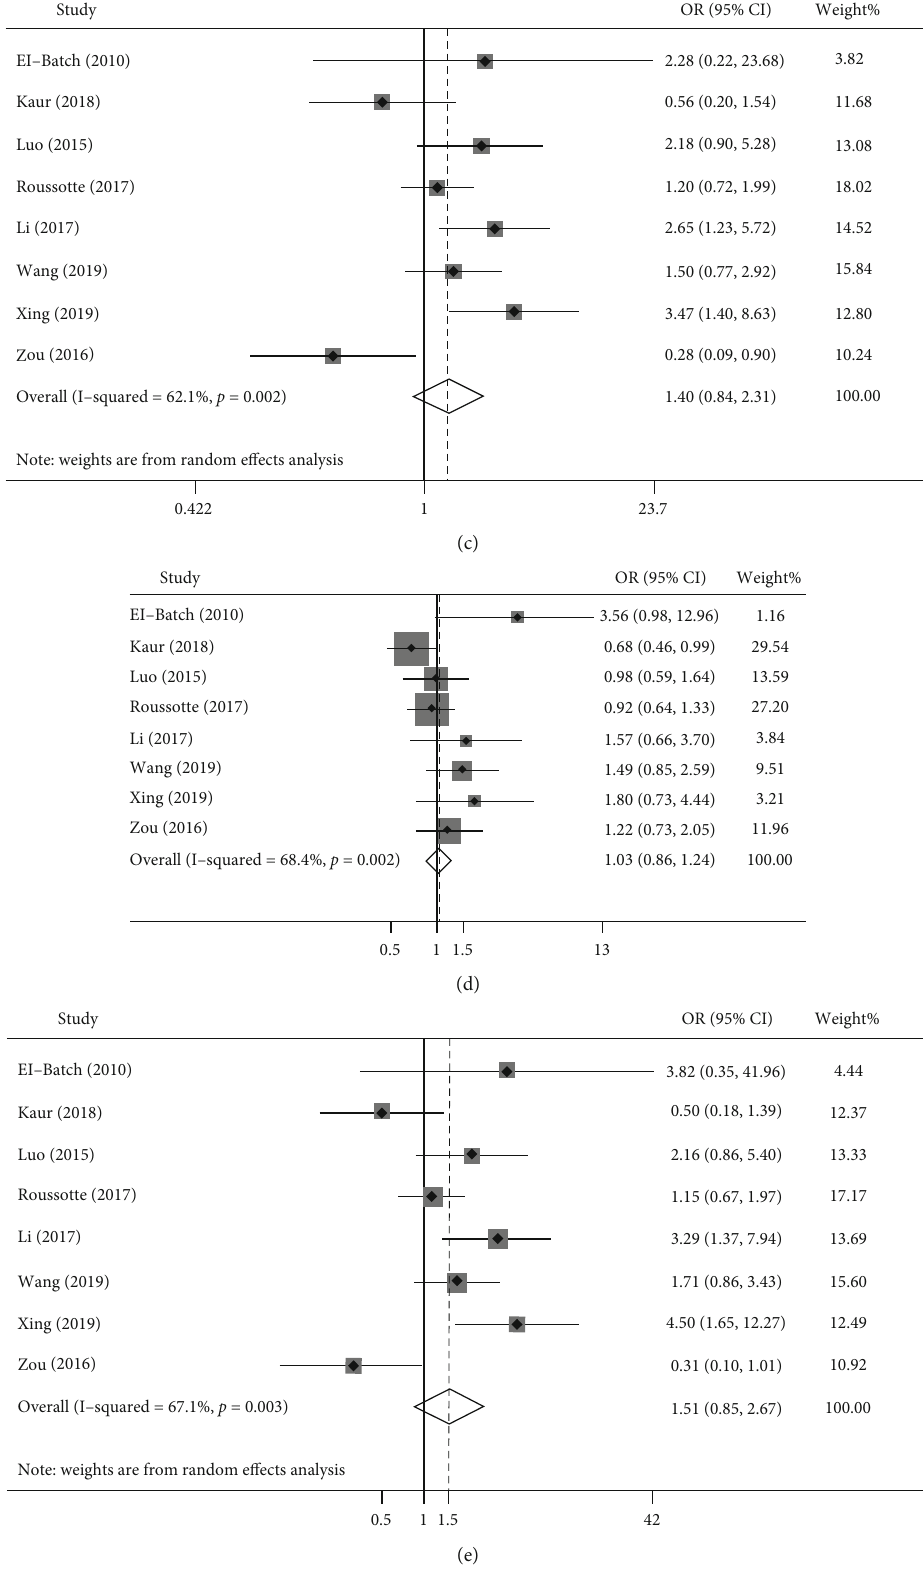
Figure 2: Forest plots of fi ve gene models for the association between MTHFR C677T polymorphisms and mild cognitive impairment. (a) Allelic model (T vs. C), (b) dominant model (CT+TT vs.CC), (c) recessive model (TT vs. CC+CT), (d) heterozygous model (CT vs. CC), and (e) homozygous model (TT vs.